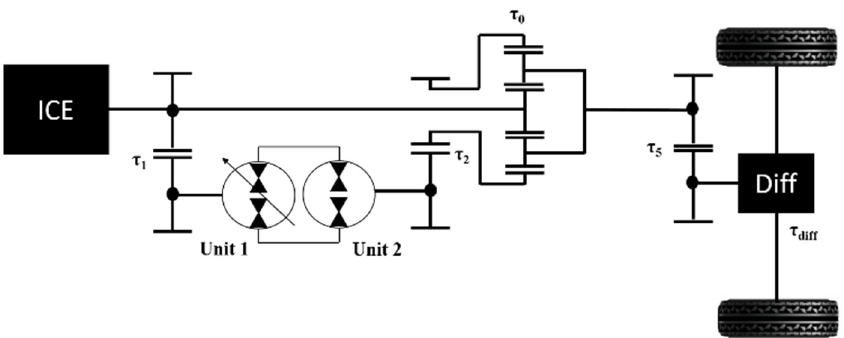
Figure 3. Scheme of input-coupled transmission.